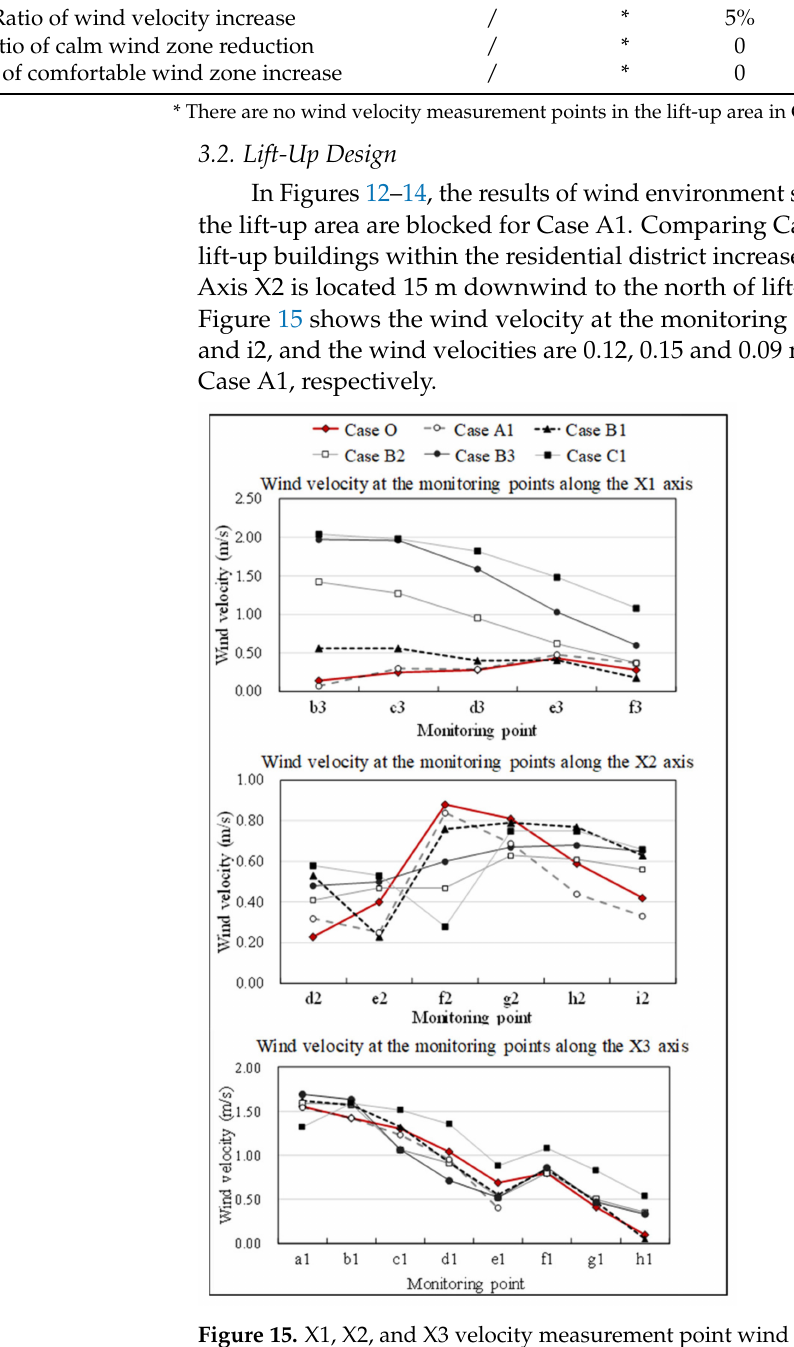
Figure 15. X1, X2, and X3 velocity measurement point wind velocities for the six cases. However, the lift-up design in Case O does not improve the low wind velocity envi- ronment throughout the entire residential area. Table 2 indicates that the overall average wind velocity in Case A1 is 0.69 m/s, and the comfortable wind zone ratio is 22%. The overall wind comfort zone in the residential area remains limited. There are no velocity measurement points in the lift-up area in Case A1, so the average wind velocities